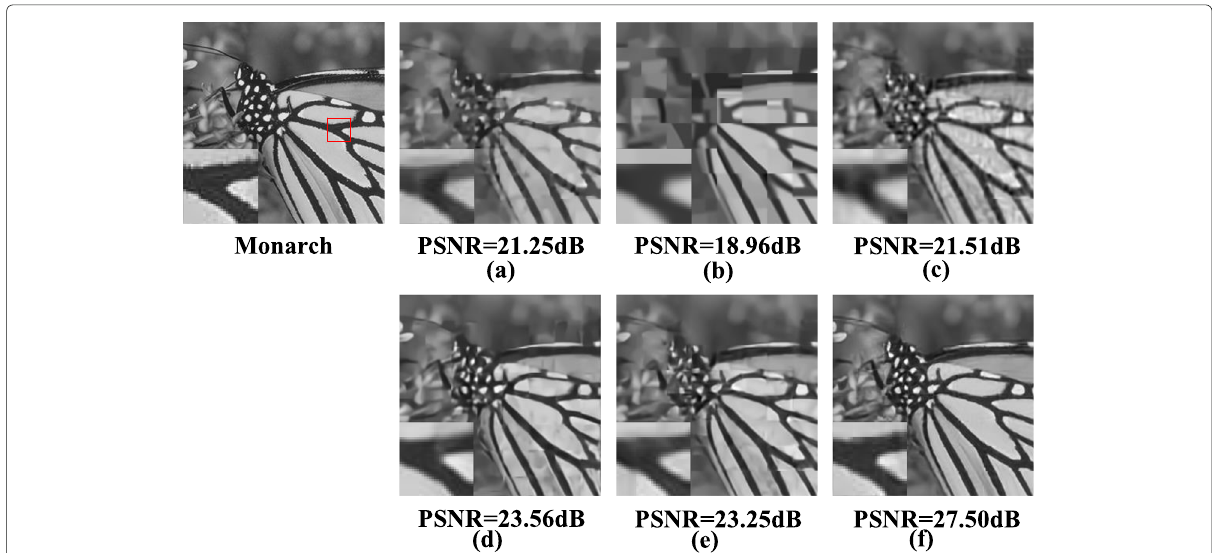
Fig. 8 The reconstruction results of Monarch at the measurement rate of 0.1 with BM3D. a TVAL3. b DAMP. c ReconNet. d DR 2 -Net. e